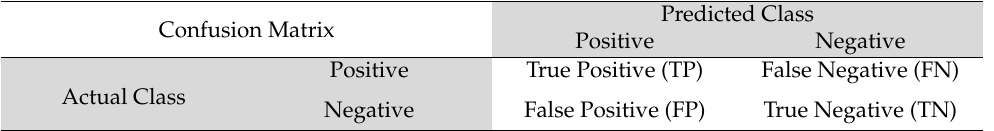
Table 4. Simple confusion matrix. Confusion